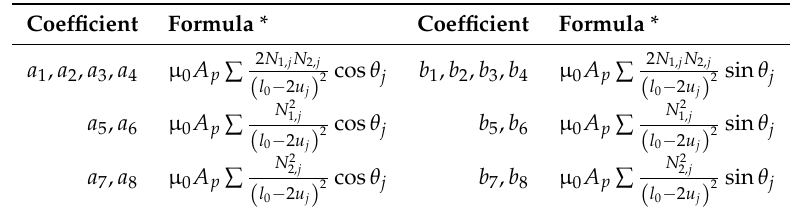
Table 1. Position-dependent coefficients for the bearing force Equations (5) and (6)